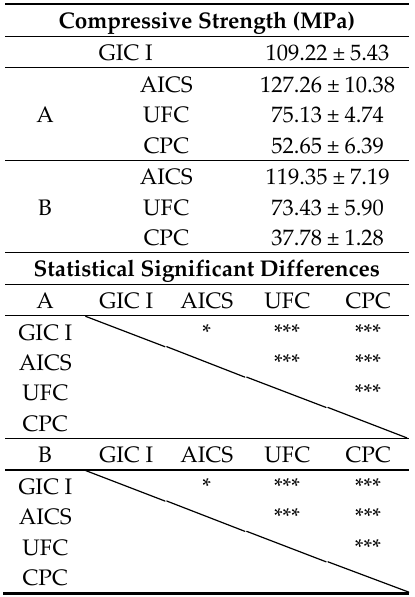
Table 4. After stored in artificial saliva at 37 °C for 23 h, the compressive strengths of specimens prepared using the two sets of conditions in Experiment I, and the results of statistical analyses. ( n = 6/group).